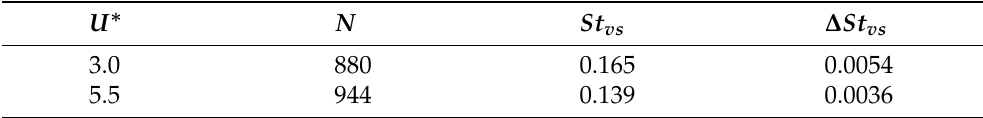
Table 1. The number of snapshots N , vortex-shedding frequency, and sampling frequency ∆ St used in the POD for the different cases.